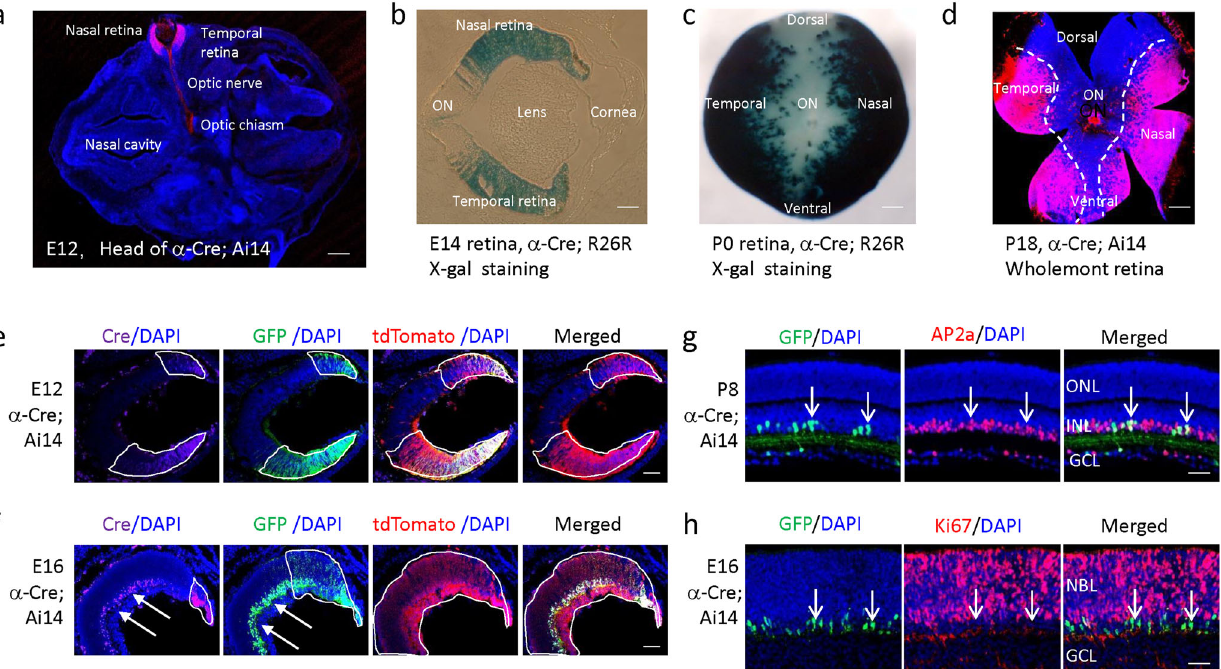
Fig. 4 α -Cre activity in the retina. a Horizontal sections of α -Cre;Ai14 head at E12, showing tdTomato in the nasal and temporal peripheral retina as well as RGC axons in the optic nerve and optic chiasm. b X-gal staining of α -Cre;R26R eyeball at E14, showing α -Cre activity in the nasal and temporal peripheral retina. c , d X-gal staining of α -Cre;R26R whole retina at P0 ( c ), and tdTomato fl uorescence in α -Cre;Ai14 at P18 both showing α -Cre activity in the nasal and temporal peripheral retina but not the dorsal and ventral retina. e Horizontal sections of α -Cre;Ai14 retina at E12, showing α -Cre expression (anti-Cre immuno fl uorescence), GFP expression (anti-GFP immuno fl uorescence), and lineage tracing (tdTomato fl uorescence) in the nasal and temporal peripheral retina. f Horizontal sections of α -Cre;Ai14 retina at E16, showing Cre and GFP in amacrine cells (white arrows). g AP2a staining (red) of P8 α -Cre retina, white arrows show typical GFP + ; AP2a + cells. h Ki67 staining (red) of E16 α -Cre retina; white arrows show typical GFP + ;Ki67 - cells. The white boxes in e , f represent the expression areas of Cre, GFP or tdTomato in retinal progenitors, respectively. ON, optic nerve; ONL, outer nucleus layer; INL, inner nucleus layer; GCL, ganglion cell layer; NBL, neuroblastic cell layer. Scale bars: a 200 µ m; c – h 50 µ